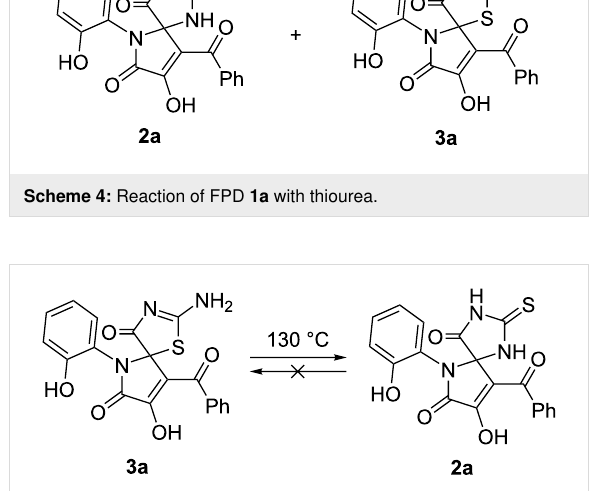
Figure 2: Electrophilic centers of FPDs 1 , starting materials of this study.